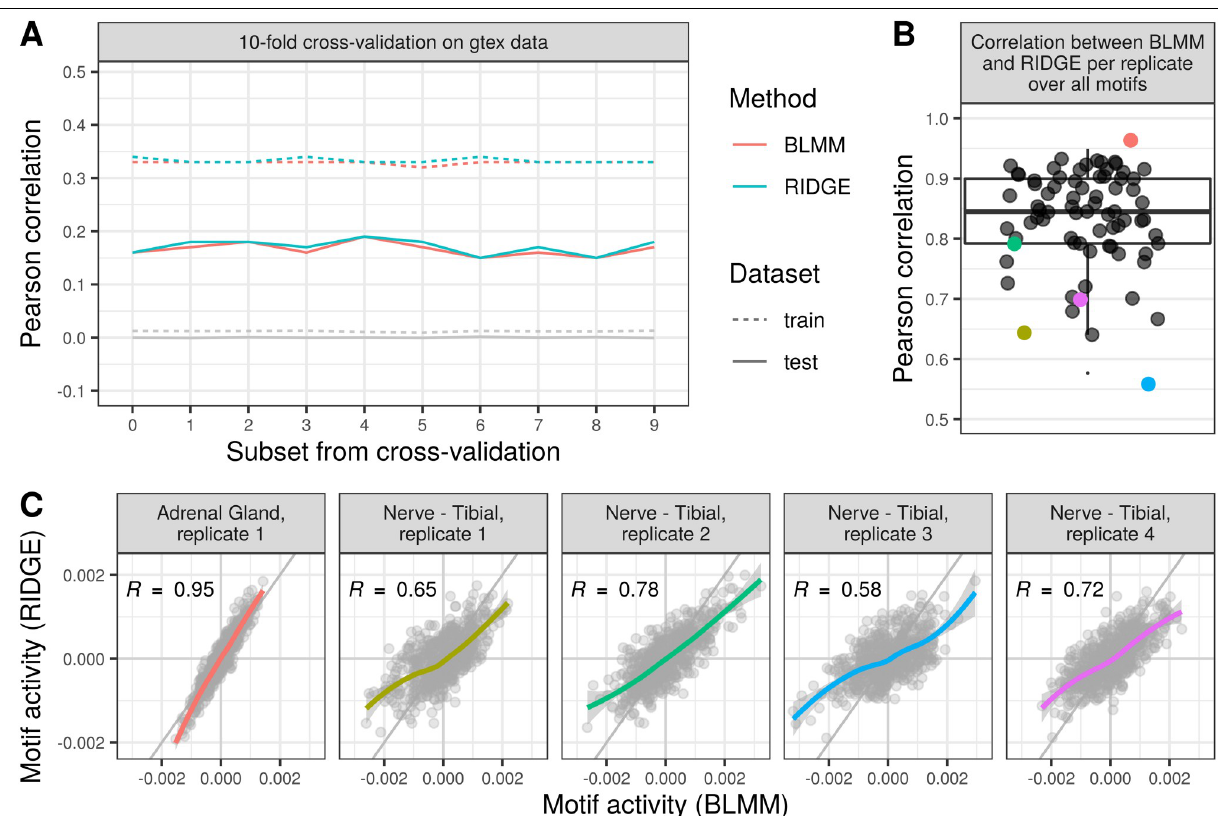
Fig 4. Data application on GTEx data. (A): Pearson correlation values between training set and predicted gene expression of training set and between the test set of the gene expression data and the predicted gene expression of ten-fold cross-validation for Bayesian Linear Mixed Model (BLMM, in red) and Ridge Regression (RIDGE, in blue). In gray, the mean Pearson correlation between predicted and real signal using both methods (overprinted lines show high concordance) with a 1000-fold randomization of motif scores is shown. (B): Pearson correlation of estimated motif scores on the basis of the Ridge Regression and the Bayesian Linear Mixed Model. Per correlation value, all motif scores are taken per replicate. Examples shown in (C) are colored according to respective color. (C): Exemplary scatter plots of tissue replicates, on which the Pearson correlation for the posterior motif influence ^ o is high or low between the two methods, Bayesian Linear Mixed Model and Ridge Regression, as colored in (B). The values along the x-axis result T ; C from the Bayesian Linear Mixed Model, assuming dependence between samples, and on the y-axis from assuming independence (Ridge Regression). The diagonal is shown in gray and the overall trend of the data is shown with its 95% confidence interval.